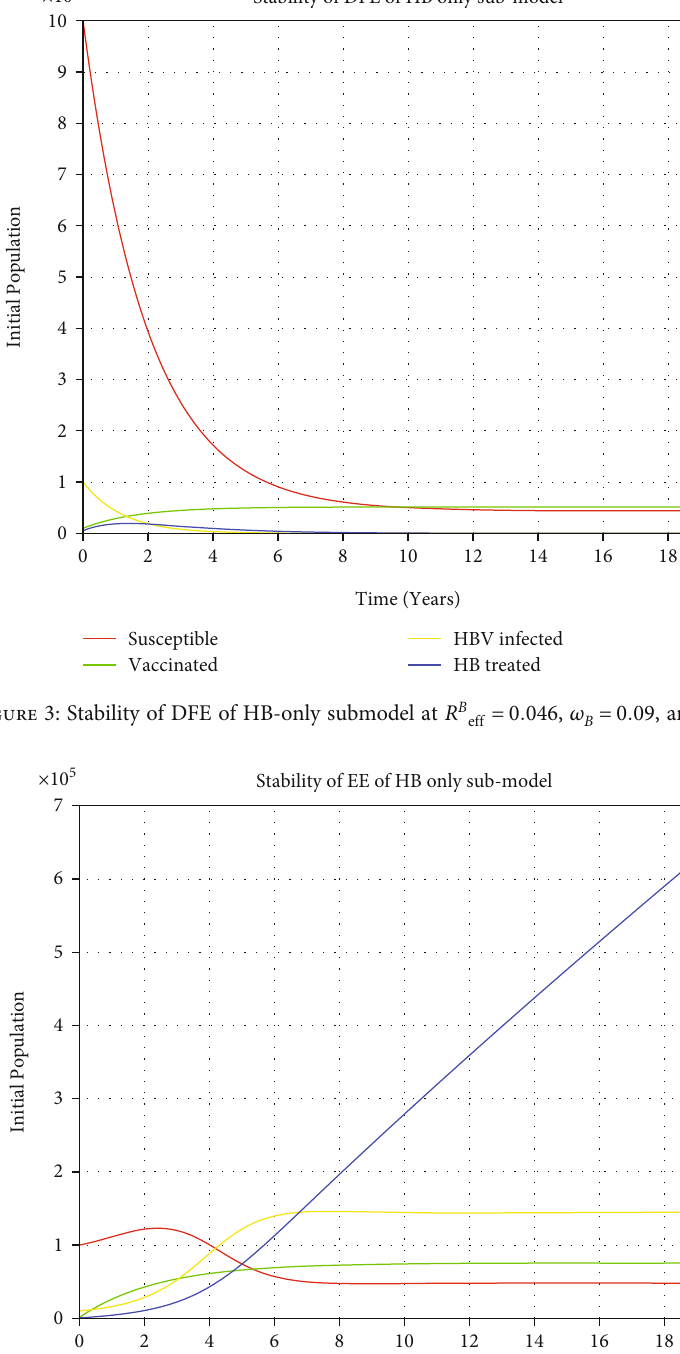
Figure 4: Stability of EE of HB-only submodel at R B